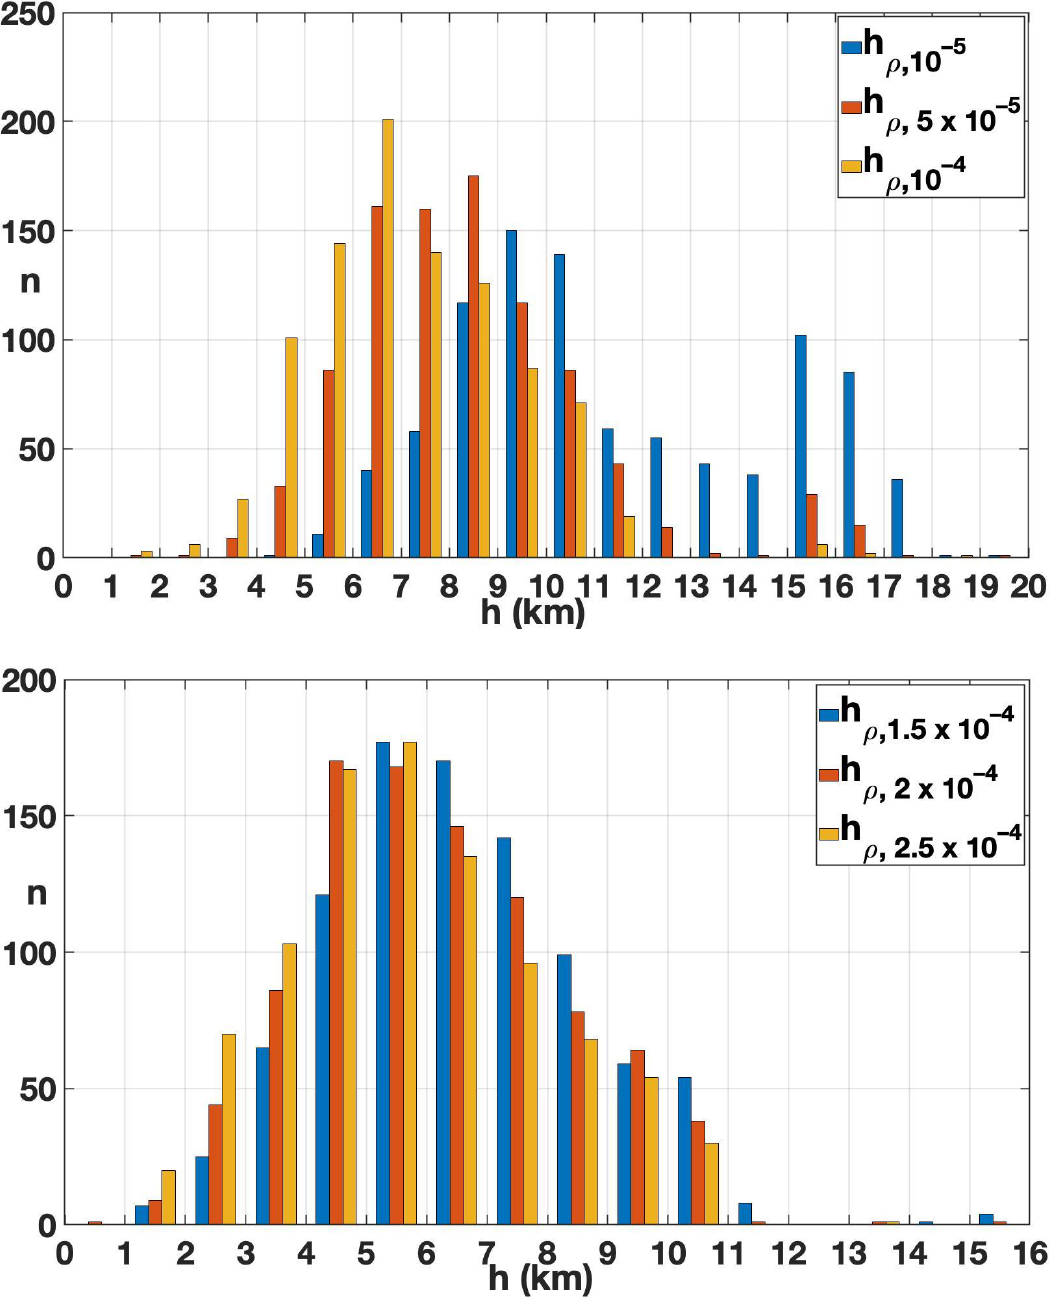
Figure 10. Distribution histograms for the dry air starting altitudes ℎ 𝜚,10 −5 , ℎ 𝜚,5×10 −5 , ℎ 𝜚,10 −4 ( top ) and ℎ 𝜚,1.5×10 −4 , ℎ 𝜚,2×10 −5 , ℎ 𝜚,2.5×10 −4 ( bottom ). Means and standard deviations for these distributions are reported in Table 2.